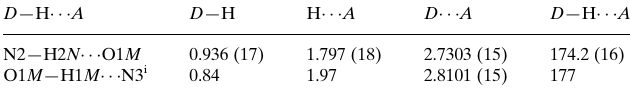
Hydrogen-bond geometry (A˚ , (cid:3)